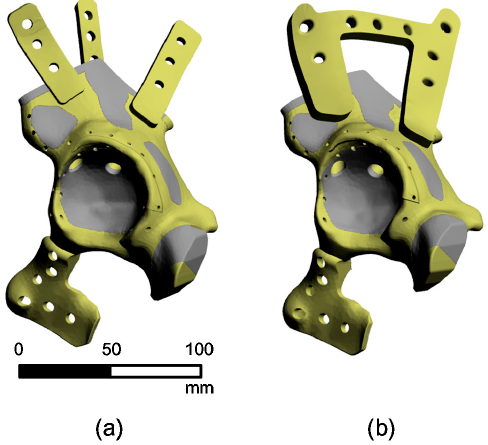
Figure 2. 3D model of the periacetabular implant and femur shaft area. The implant fixation models with ( a ) the straight-type plates and ( b ) the horseshoe-shaped plates.